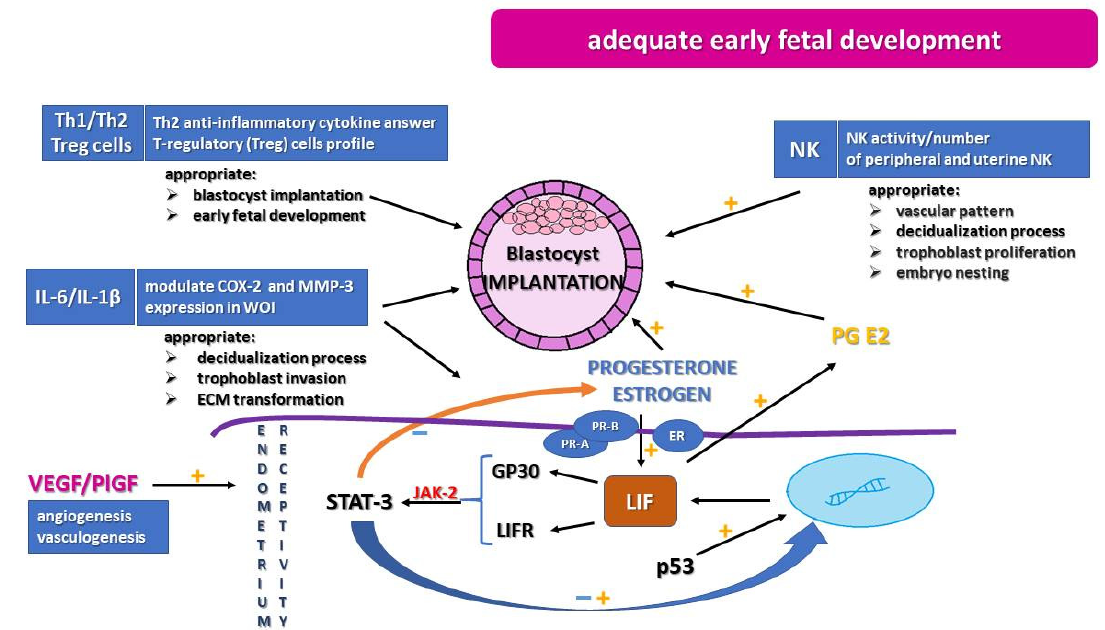
Figure 1. Creation of utero environment for appropriate endometrium receptivity, trophoblast proliferation, and embryo nesting. COX-2, cyclooxygenase-2; ECM, extracellular matrix; ER, estrogen receptors; GP130, glycoprotein 130; IL-1 β , interleukin-1 β ; IL-6, interleukin-6; JAK-2, Janus kinase 2; LIF, leukemia inhibitor factor; LIFR, membrane LIF receptor; MMP-3, metalloproteinase-3; NK, natural killer; p53, tumor protein p53; PlGF, placental growth factor; PR-A/PR-B, progesterone receptors; STAT-3, signal transducer and activator of transcription 3; Th1/Th2, T cells involved in inflammatory response; Treg, T-regulatory cell profile; WOI, window of implantation; VEGF, vascular endothelial growth factor.